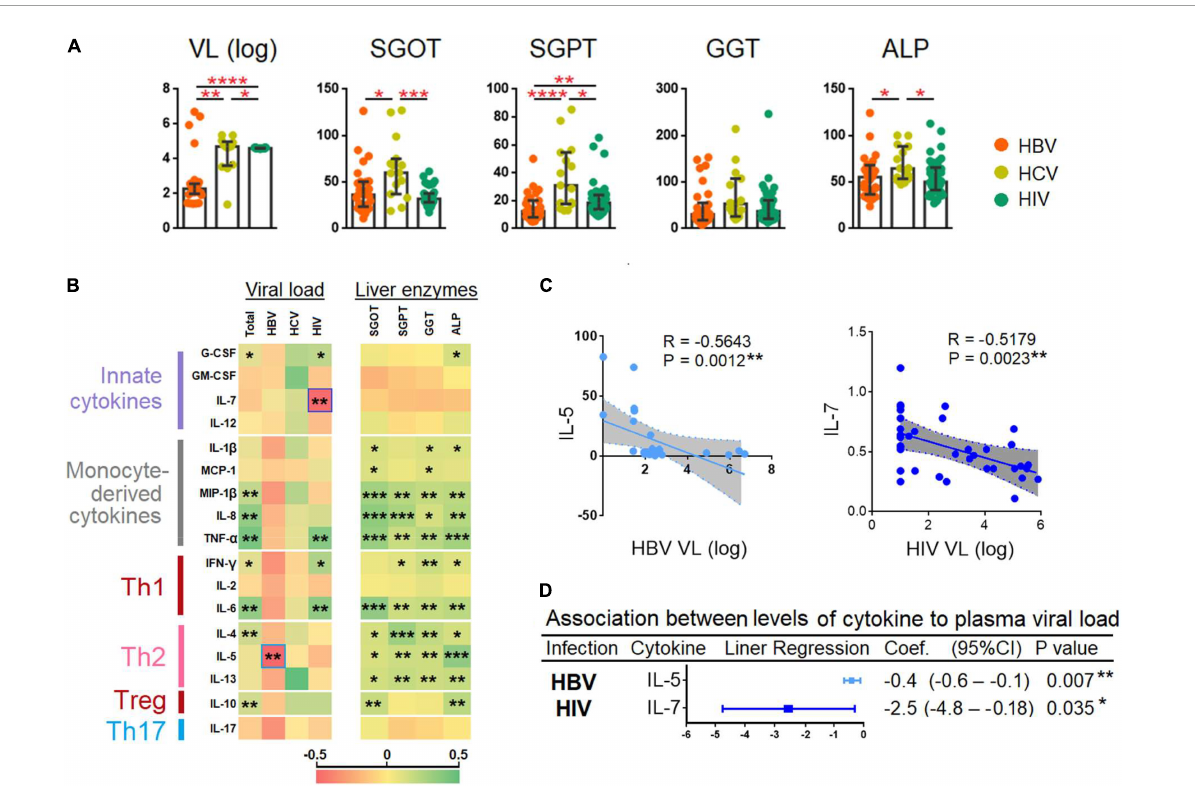
FIGURE4 Correlation between plasma viral loads, levels of liver transaminases, and cytokines. (A) Comparison between plasma viral loads (PVL) and liver enzymes among patients chronically infected with HBV, HCV, and HIV. The cytokines were compared across the three patient groups by a Kruskal–Wallis test. Post-hoc Mann–Whitney U tests were subsequently performed for those biomarkers with a Kruskal–Wallis test p -value of < 0.05. (B) Spearman correlation of viral load and liver enzymes and the 17 cytokines. The R-value of each comparison was reflected by the color scale of the heatmap. (C) Spearman correlation of the two cytokines that had an inverse correlation with PVL. The exact R- and P -values were calculated. (D) Association between the levels of cytokines with PVL. P -values < 0.05 are considered significant in all tests; * p < 0.05, ** p < 0.01, *** p < 0.001, **** p < 0.0001. HBV, hepatitis B virus; HCV, hepatitis C virus; HIV, human immunodeficiency virus; HC, healthy control; SGOT, serum glutamic oxaloacetic transaminase; SGPT, serum glutamic-pyruvic transaminase; GGT, gamma-glutamyl transferase; ALP, alkaline phosphatase; VL, viral load.